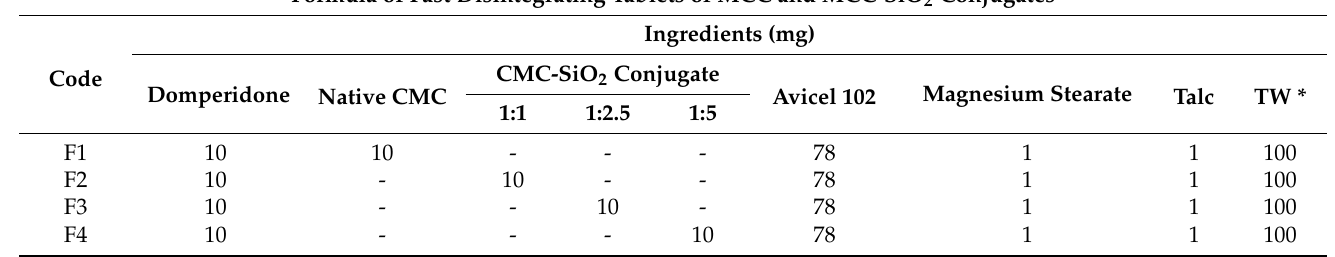
Table 1. Formula of fast disintegrating tablets of MCC and MCC-SiO 2 conjugates and formula of fast disintegrating tablets of CMC and CMC-SiO 2